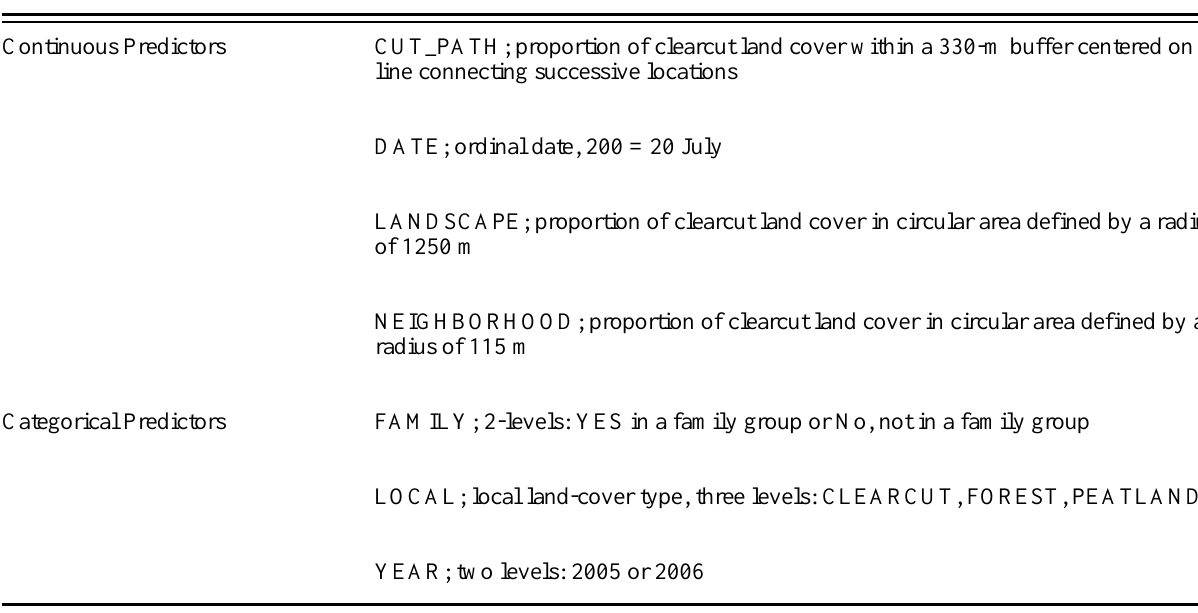
Table 1. Model terms used in movement-rate models to assess residency time and landscape connectivity. Continuous